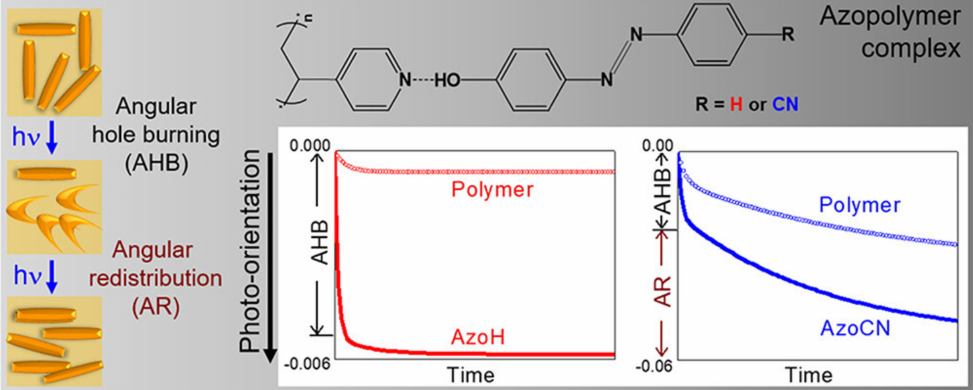
Figure 3. Supramolecular complexes of poly(4vinylpyridine) (P4VP) with 4-phenylazophenol (A H , R = H) and 4-hydroxy- 4 (cid:48) -cyanoazobenzene (A CN , R = CN), and photoinduced orientation as a function of time during orientation (laser on) of P4VP/A CN (100%) and P4VP/A H (100%). Reprinted with permission from reference [103]. Copyright (2018) American Chemical Society.